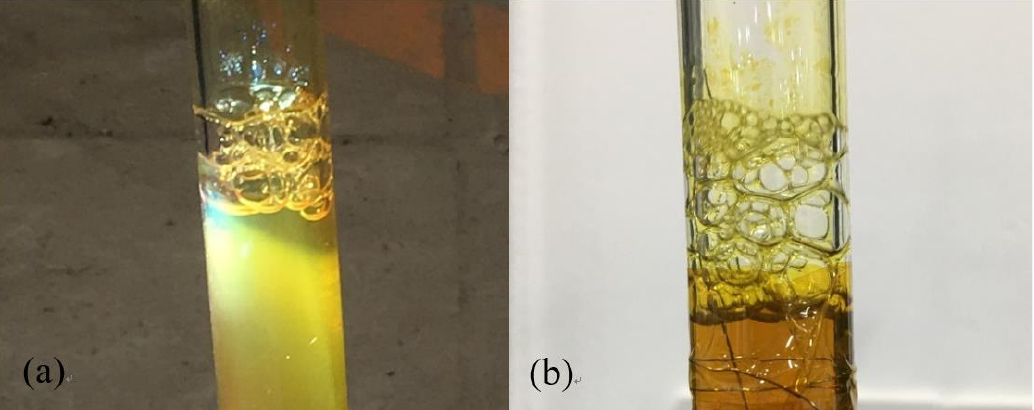
Figure 13. Boiling of Ag nanofluids ( a ) under the focused sunlight of 220 suns, ( b ) with the heating of resistance wire.